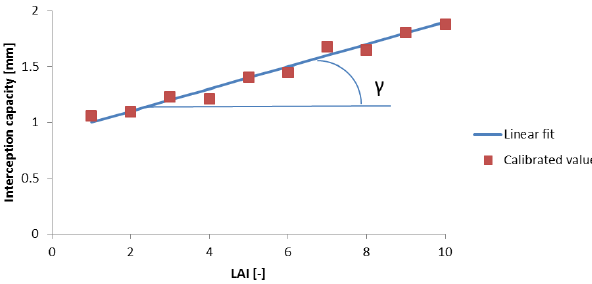
Figure 4. Function relationship between leaf area index (LAI) and the hydrologic parameter interception capacity ( I 0 , max ) defined by the global parameter γ , based on fictional data for